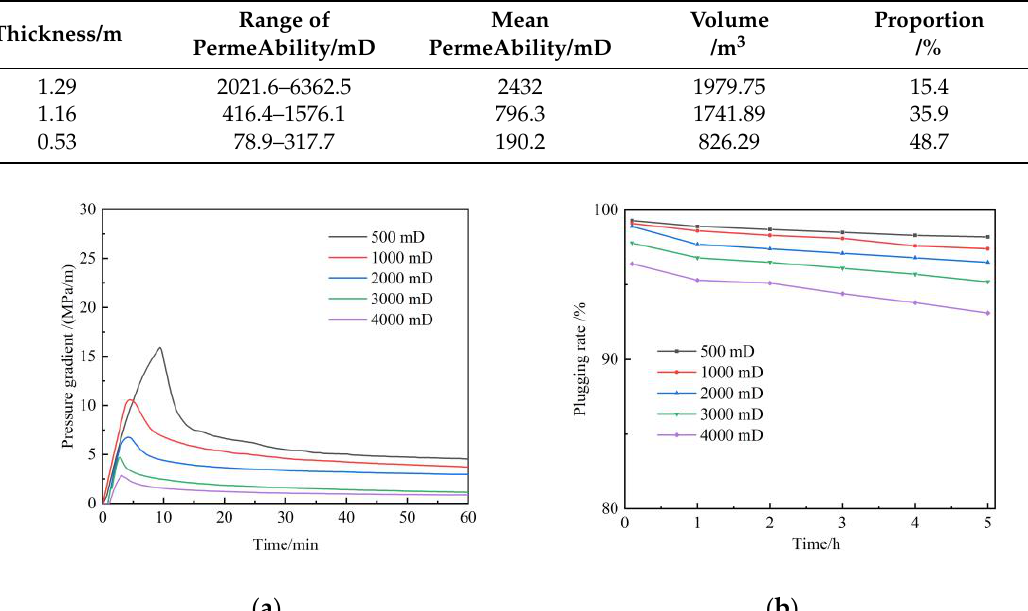
Figure 12. Plugging performance of polymer gel during flue gas flooding: ( a ) Breakthrough pressure gradient; ( b ) Plugging rate.